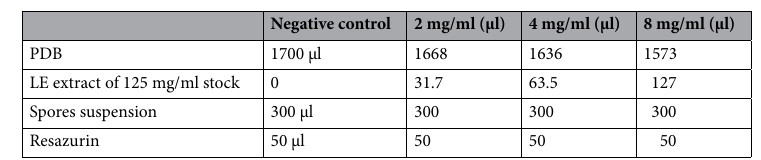
Table 7. Spores germination experimental